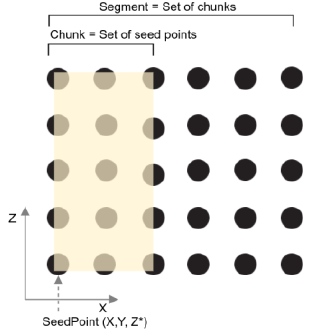
Figure 5. Visual representation of a seed point, chunk and